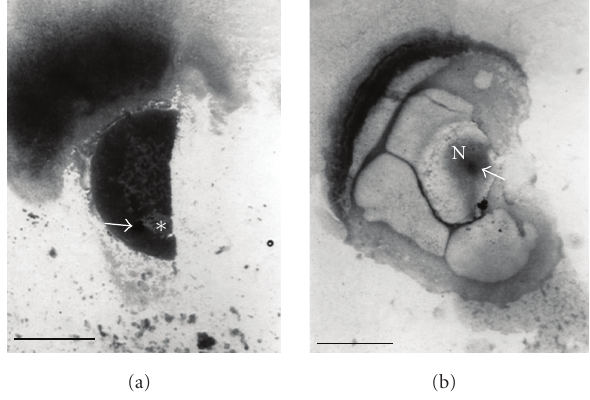
Figure 9: (a): Ventral view of living hemisectioned unincubated chicken blastoderm (right side), at the start of the culture period: the median part of the right Rauber’s sickle half has been removed and the deep side of the upper layer is visible ( ∗ ); graphite particle on the cross sectioned part of Rauber’s sickle (indicated by white arrow). Bar = 2mm. (b): The same hemi-embryo as in Figure 9(a), after 25 hours of culture: a rectilinear primitive streak, with tissue on both sides, starts from the cross-sectioned part of Rauber’s sickle (graphite particle) in the direction of the nodus (indicated by white arrow) and neural plate (N). Bar = 2